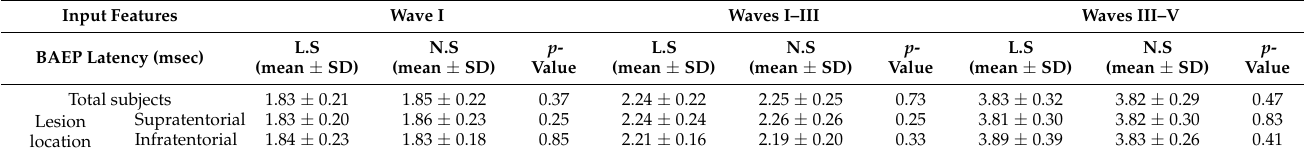
Figure 5. Reference delta K-MBI versus regressed delta K-MBI using ( a ) ANN and ( b ) SVM with the basal K-MBI score, age, and BAEP IPLs. The red lines indicate the linear regression lines. Table 3. Comparisons between lesion and nonlesion sides (mean ± SD).